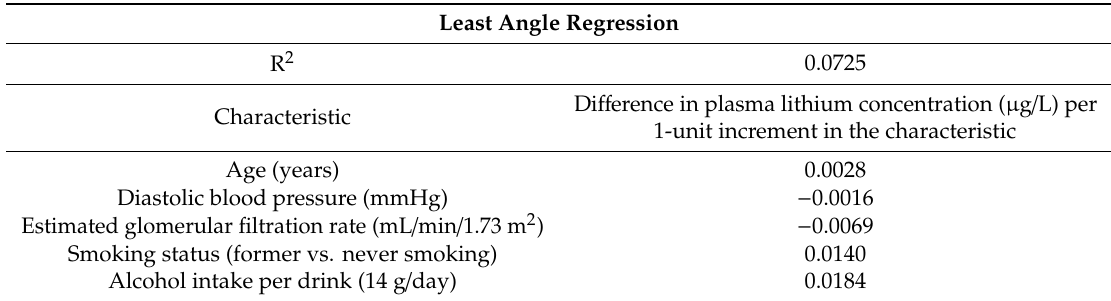
Table3. SelectedpredictorsforlithiumplasmaconcentrationbyusingLeastAngleRegressionalgorithm.